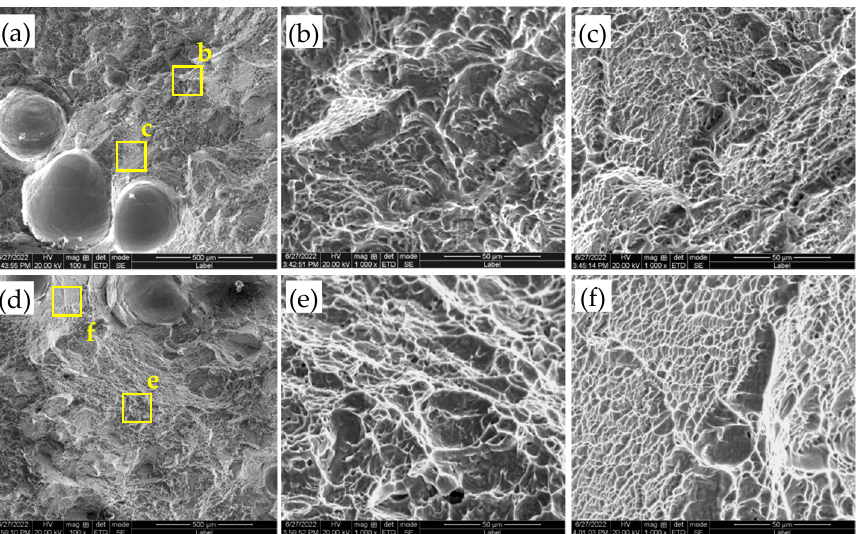
Figure 18. Typical tensile fractured morphology in arc zone of welded joints with different currents: ( a – c ) I = 30 A; ( d – f ) I = 50 A.